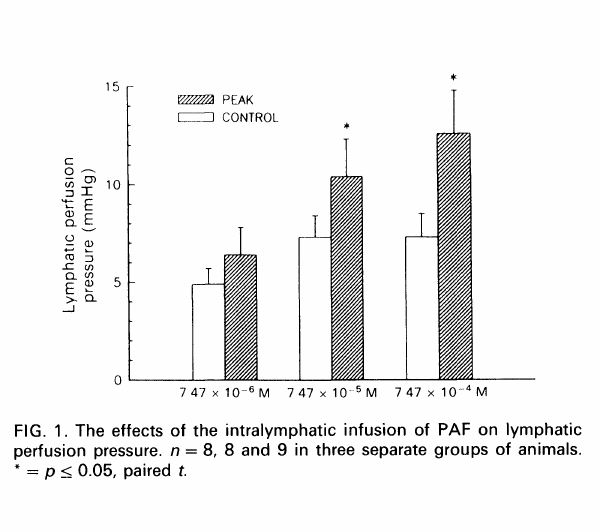
FIG. 1. The effects of the intralymphatic infusion of PAF on lymphatic perfusion pressure, n 8, 8 and 9 in three separate groups of